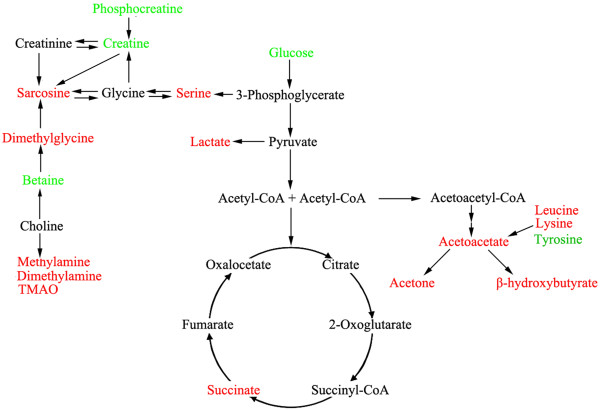
Disturbed metabolic pathways of the most relevant metabolites between rectal cancers and normal controls. Green: lower concentration in rectal cancer patients than in normal controls. Red: higher concentration in rectal cancer patients than in normal controls.